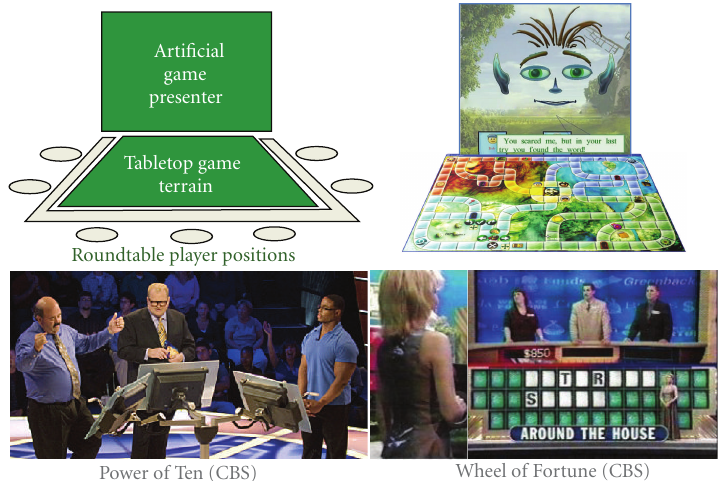
Figure 1: Setup of the Amby presenter character for a tabletop game, resembling TV-show